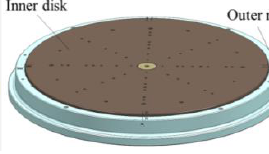
( c ) Figure 7. ( a ) Multi-station switching device and supporting tool — L-shaped bracket; ( b ) mul- ti-station switching device and supporting tool — U-shaped bracket; ( c ) multi-station switching de- vice and supporting tool — switching ring.